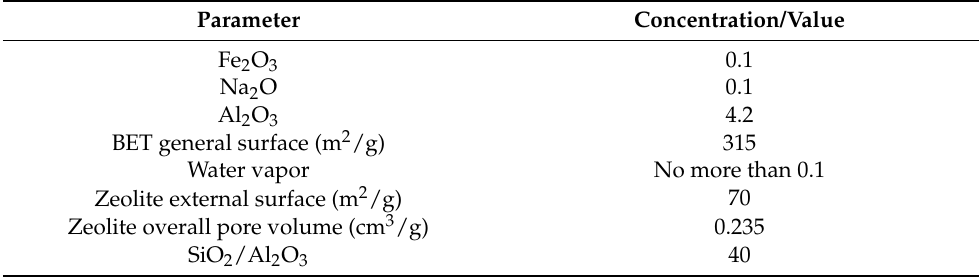
Table 2. Characteristics of the synthetic zeolite